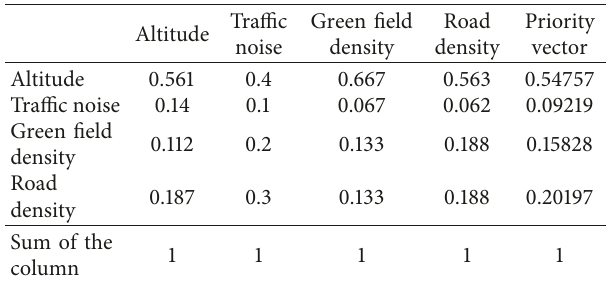
Table 3: Normalization and priority vector values of the criteria.